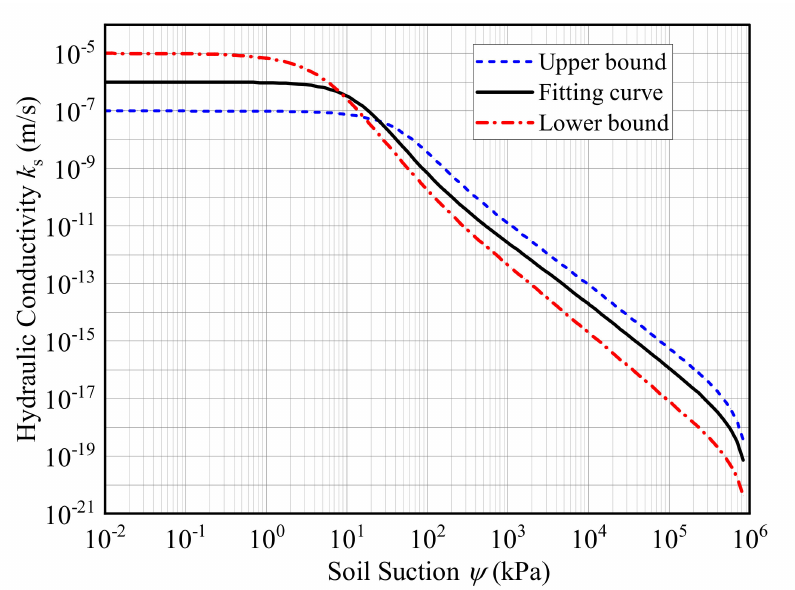
Figure 2. Illustrated the estimated HCF from best-fitted SWCC, upper and lower